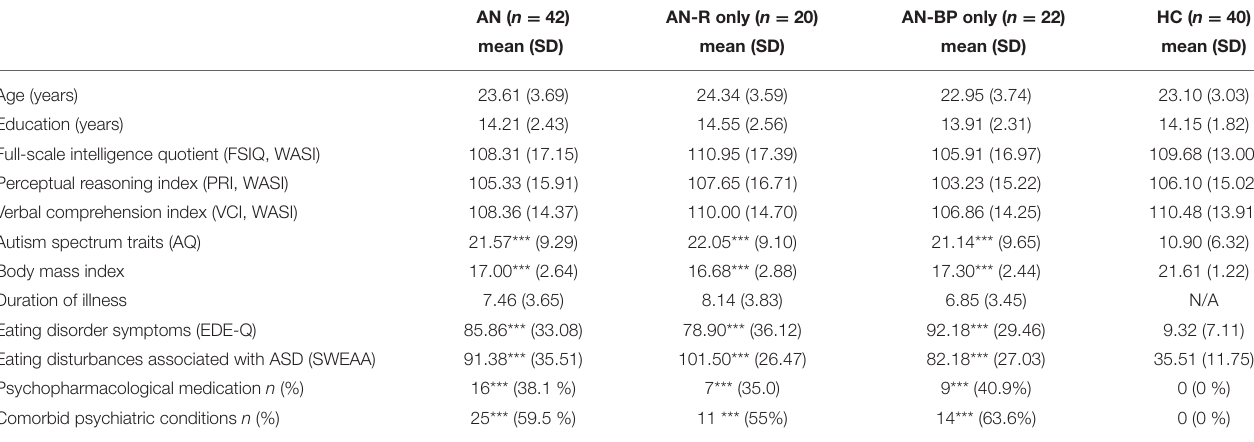
TABLE 1 | Characteristics of the AN and HC